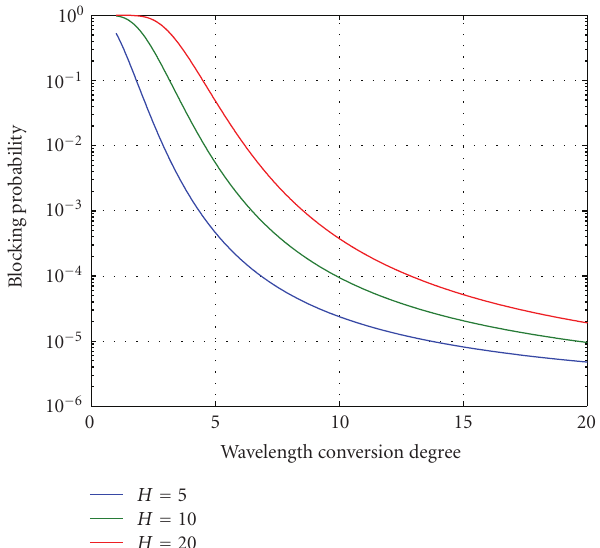
Figure 5: The blocking probability P b = f ( k ), ρ = 0 . 5, W = 20, and F = 1.